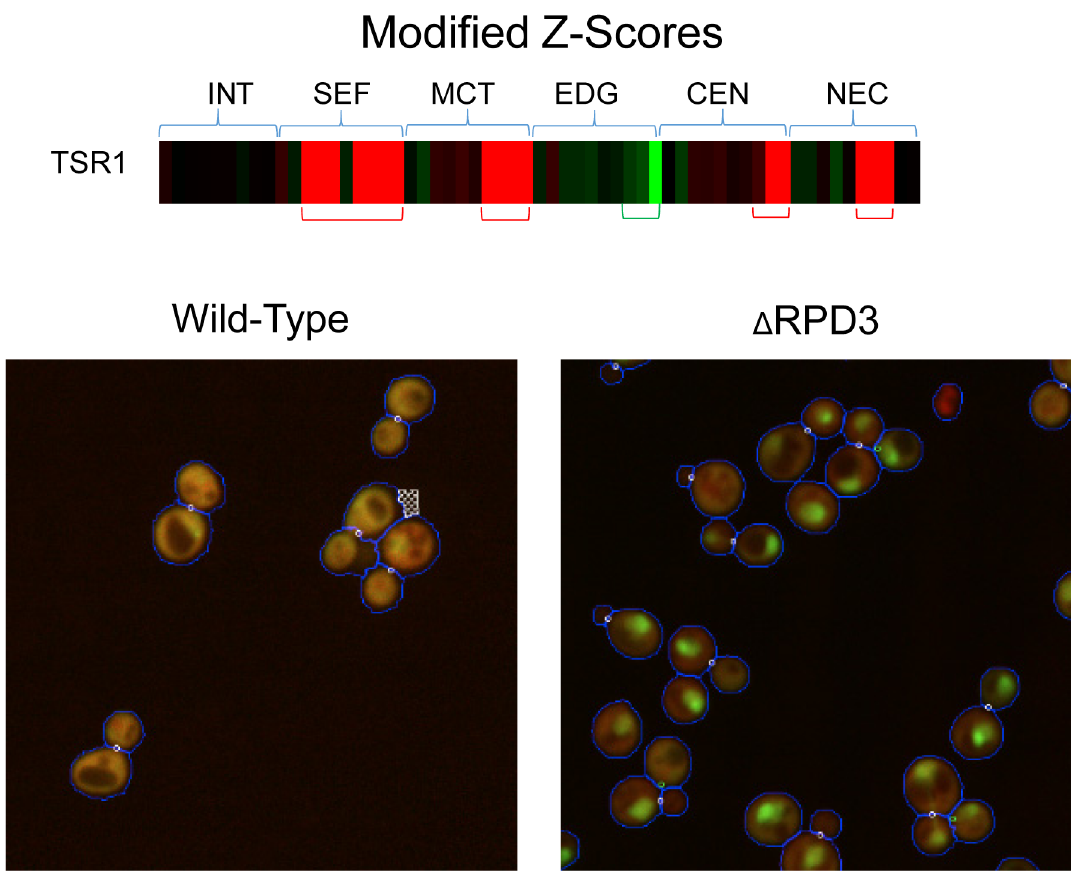
Fig 6. Modified z-score vectors can be interpreted to determine direction of feature-wise change. We show the modified z-score vector for TSR1 as a heat map (more information in “ Visualization of Results ” section in the Methods) and representative images of TSR1 for the wild-type and the Δ rpd3 screen; TSR1 has strongly positive modified z-score in mother features for distance between proteins, distance to protein mass centre, distance to mass centre, and distance to bud neck, and negative ones in features for distance to cell periphery. Thus, we expect the former features to be larger in the wild-type than the Δ rpd3 and the latter to be larger in the Δ rpd3 than in the wild-type. In other words, we expect the GFP in Δ rpd3 mother cells to be denser, closer to the nuclei, closer to the bud neck, and further from the cell periphery relative to the wild-type. This interpretation is consistent with the localization patterns seen in the